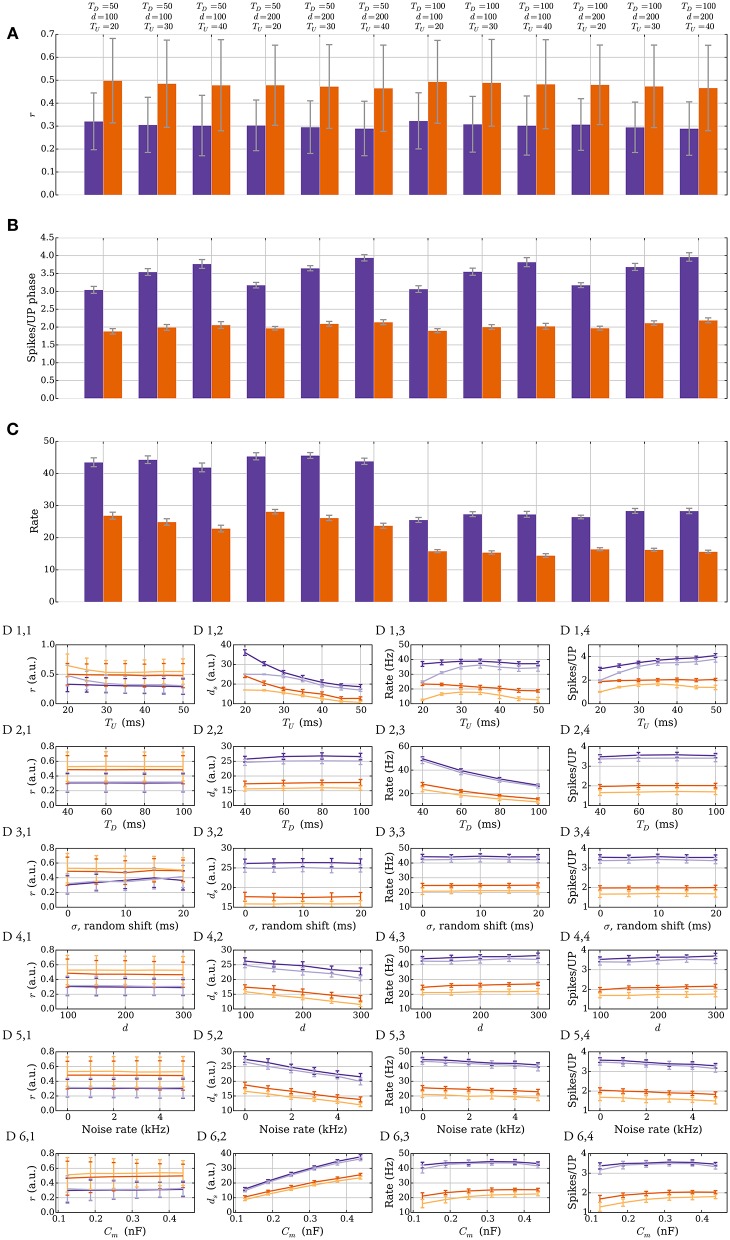
Robustness against varying input parameters in the model with leak (Section 3.2.4). (A–C) Results for two different sets of plasticity parameters corresponding to r = 1/3 (purple) and r = 1/2 (orange) in Table 3 are shown. Three parameters of the input are varied: the length of an UP phase TU; the number of input neurons d; and the length of a DOWN phase TD. (A)
r, the expected time of the first postsynaptic spike within an UP phase scaled by the UP phase length. The plasticity parameters fix r; thus, varying the input parameters has a negligible effect on it. (B) Variations in the number of spikes per UP phase. The number of spikes per UP phase depends on r, but it also has a mild dependence on the refractory period and the reset potential, which explains the variations seen when varying TU. (C) Output rate variations. The rule does not fix the output rate of a neuron: the rate depends mainly on TU and TD. (D) Single parameter variations. Variations for six different parameters are shown. The darker colored curves correspond to the same plasticity parameters as in the top three panels, and the lighter colored curves correspond to a setup with no positive feedback (pw→s = 0). The first row is for TU, the second is for TD, the third is for random phase shifts of the input neurons, the fourth is for d, the fifth is for the noise rate ν, and the sixth is for the membrane capacitance (for details see Section 3.2.4). The orange curves start with ds = 17 and the purple curves start with ds = 25. Each data point in (A–C) is the mean of 40 trials and in (D) the mean of 10 trials. The error bars represent standard deviation estimates. For each trial, the process was simulated for 200 UP phases to reach the stable state and then the data points were collected over a continued simulation of 200 UP phases (r, rate, spikes per UP phase), or at the end (ds).